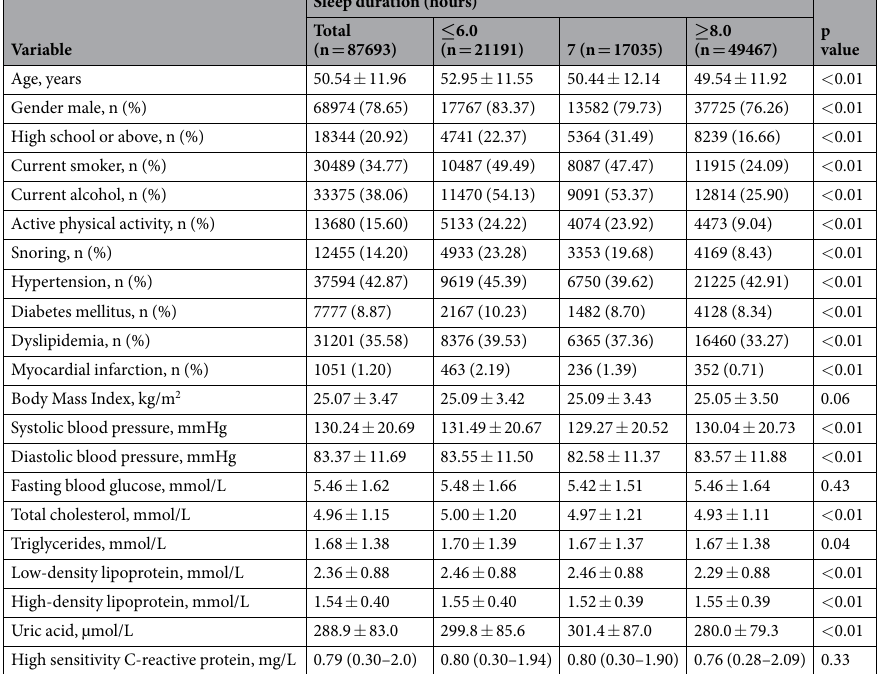
Table 1. Baseline characteristics according to sleep